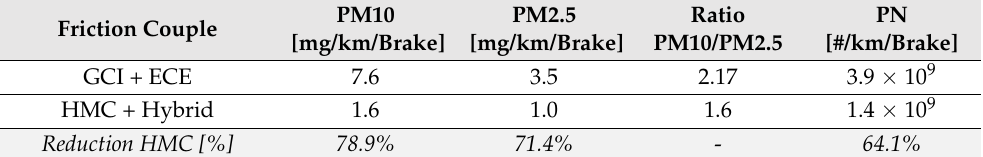
Table 9. Emission factors of the HMC pairing compared to the GCI reference.